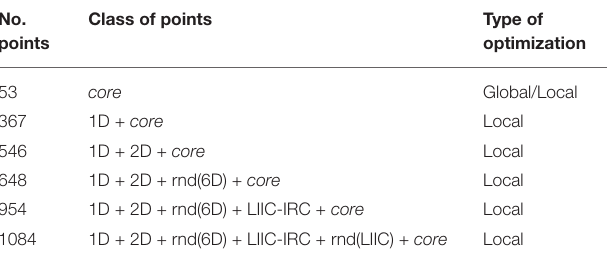
TABLE 1 | Number and description of the fitting points used in each SRP-optimization stage and the algorithm used in the process. No.